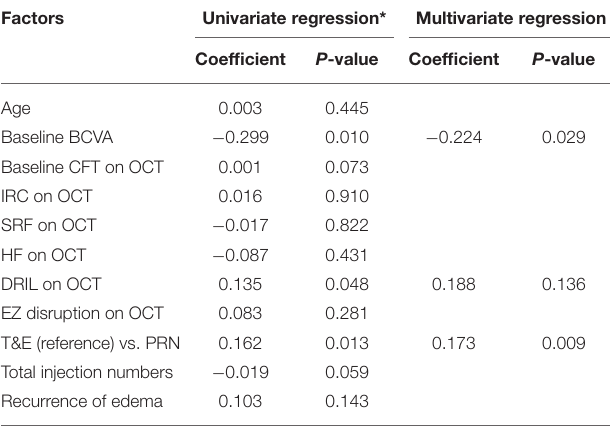
TABLE 3 | Predicting factors for best corrected visual acuity improvement at Month 24 in patients with diabetic macular edema treated with pro re nata or treat-and-extend